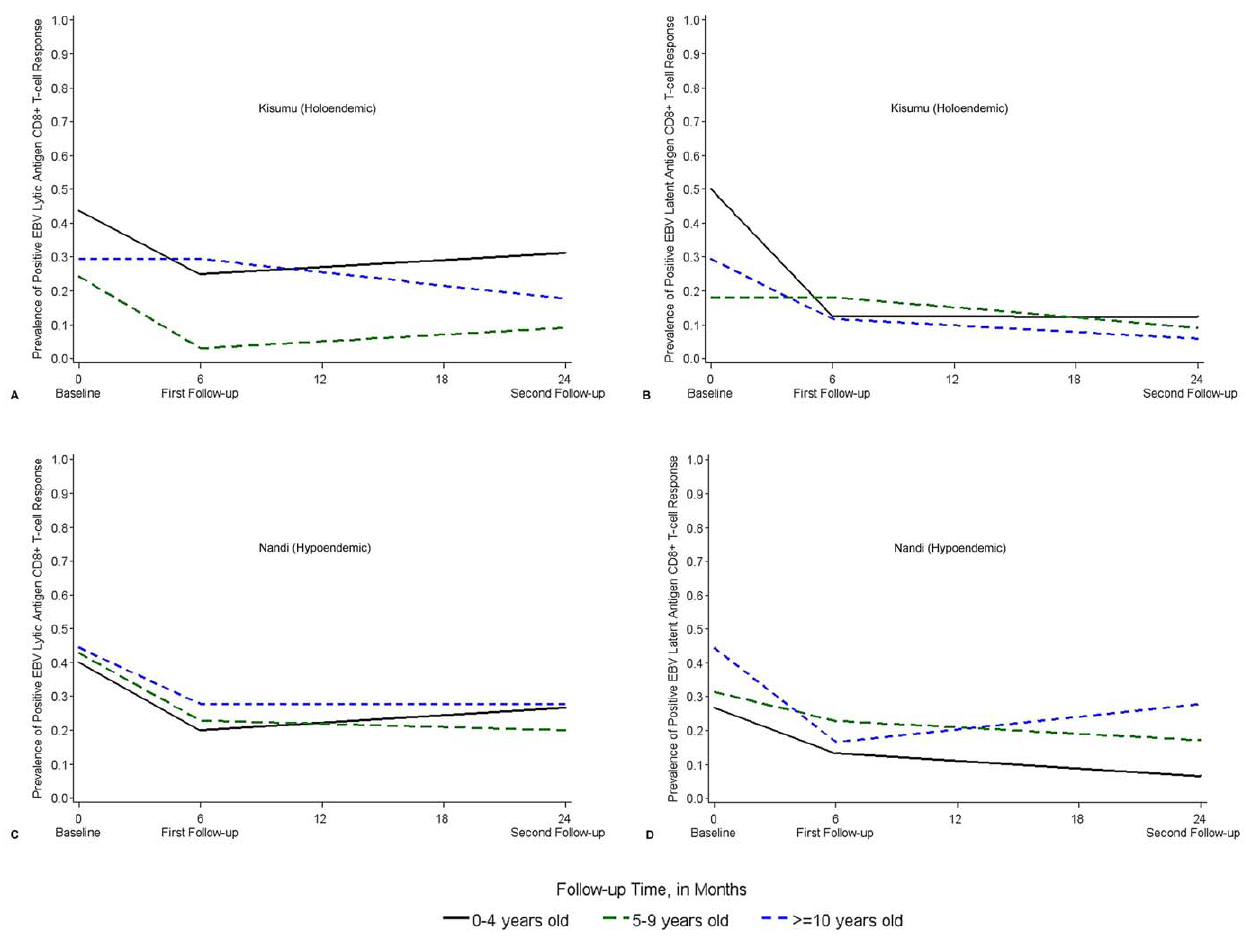
Figure 2. Change in prevalence of EBV-specific CD8 + T-cell IFN c responses with age. Changes in prevalence of positive EBV lytic (A and C) and latent (B and D) antigen CD8 + T-cell IFN c response from 2002–2004. Age group at each survey period is based on age at baseline. In Kisumu: 16 (0–4 years), 33 (5–9 years) and 17 ( $ 10 years). In Nandi: 30 (0–4 years), 35 (5–9 years) and 18 ( $ 10 years). Solid black line: 0–4 year olds; hash-mark green line: 5–9 year olds; and dotted blue line: $ 10 year old